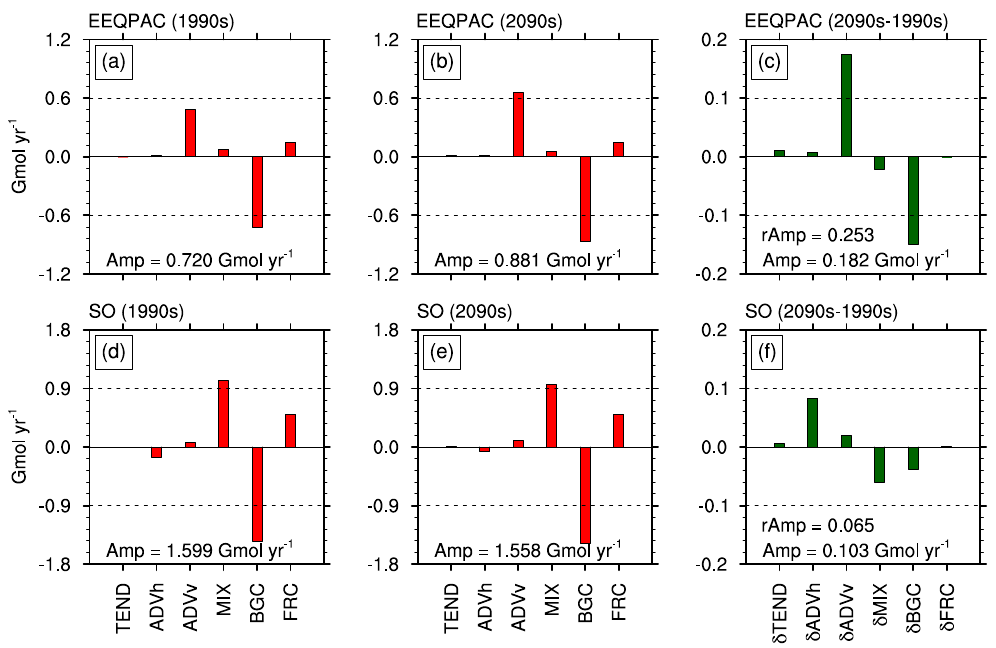
Fig. 7. Regionally integrated dissolved iron tendencies (Gmolyr − 1 ) in the upper 100m of EEQPAC (a–c) and SO (d–f) for the 1990s ( a and d ) and the 2090s ( b and e ), and the differences between the 2090s and 1990s ( c and f